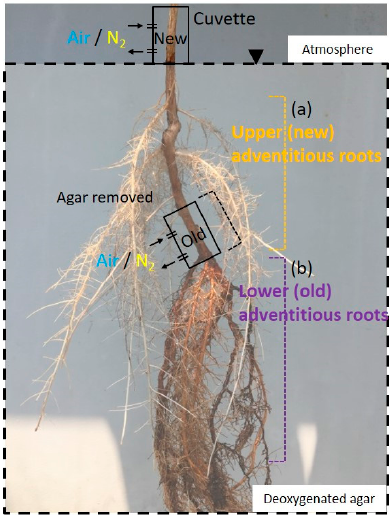
Figure 9. Entry portion of atmospheric oxygen in the stem of Syzygium kunstleri after water level elevation. ( a ) Upper (new) adventitious roots, which developed after the water level elevation treatment. ( b ) Lower (old) adventitious roots, which developed in the flooding treatment. New cuvette positioned at the 0–3-cm portion of the stem based on the elevated water level. Old cuvette positioned at the 0–3-cm portion of the stem based on the prior water level. Air and N 2 were injected through the cuvette(arrows). Arrowhead: water